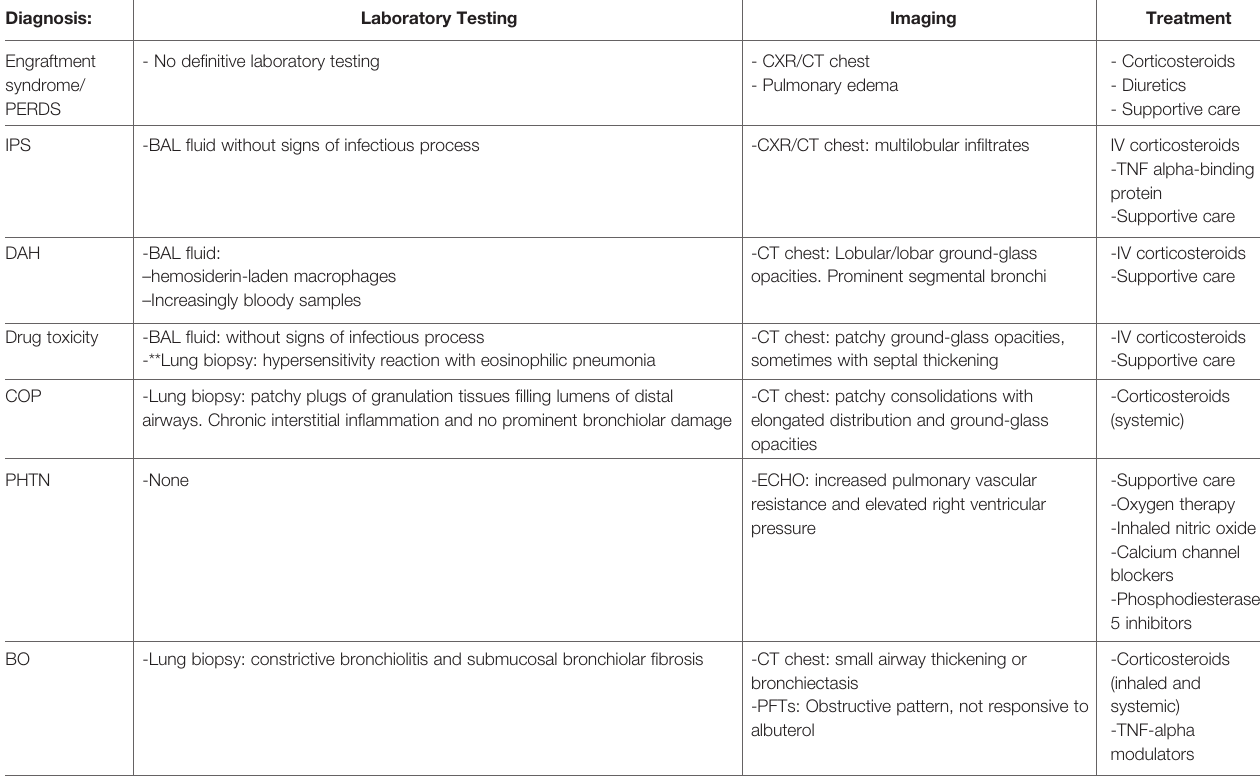
TABLE 3 | Non-infectious causes of pulmonary